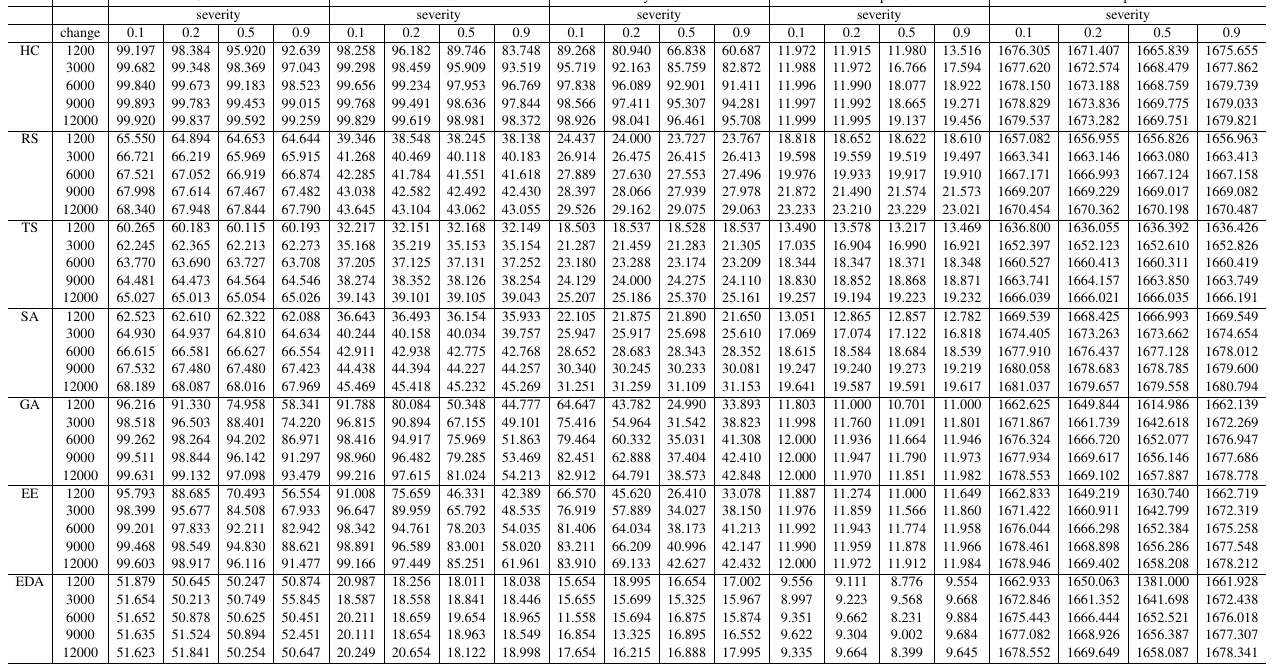
Table A.2. Offline performance obtained in 30 runs by the isolated versions of algorithms that com- pose the portfolio for each problem, severity and frequency of change.